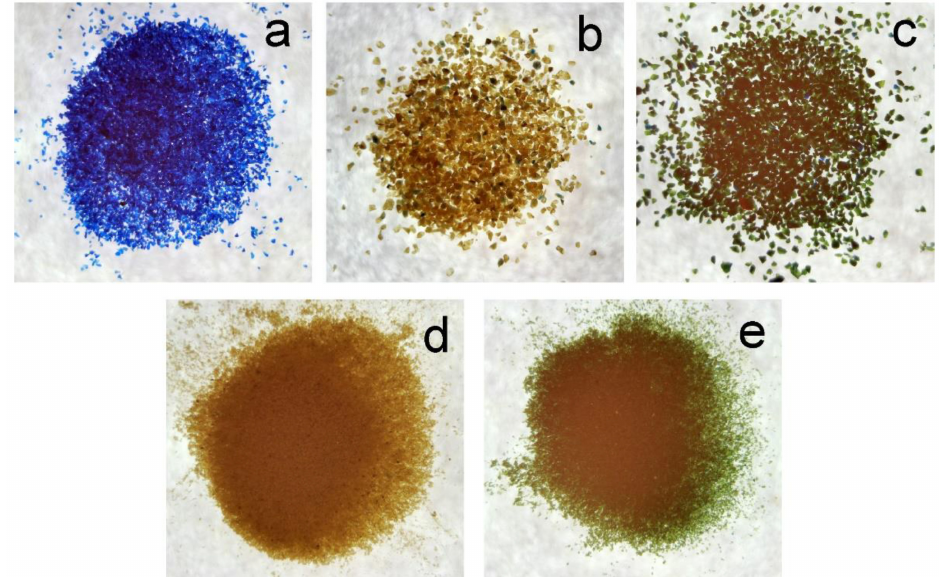
Figure 14. Color changes during heating of Sample 5: ( a ) initial sample, ( b ) 0.1–0.2 mm fraction preheated at 700 ◦ C during 3 days, over the Fe-FeS buffer, ( c ) preheated 0.1–0.2 mm fraction after annealing at 800 ◦ C during 24 h in air, ( d ) <0.04 mm fraction preheated at 700 ◦ C during 3 days, over the Fe-FeS buffer and ( e ) preheated <0.04 mm fraction after annealing at 800 ◦ C during 24 h in